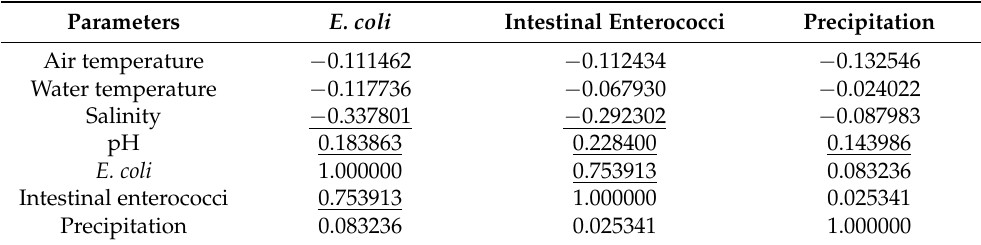
Table 4. Spearman correlation coefficients between the examined variables for both bathing seasons for the Kaštela area. Statistically significant correlations ( p < 0.05) are underlined.